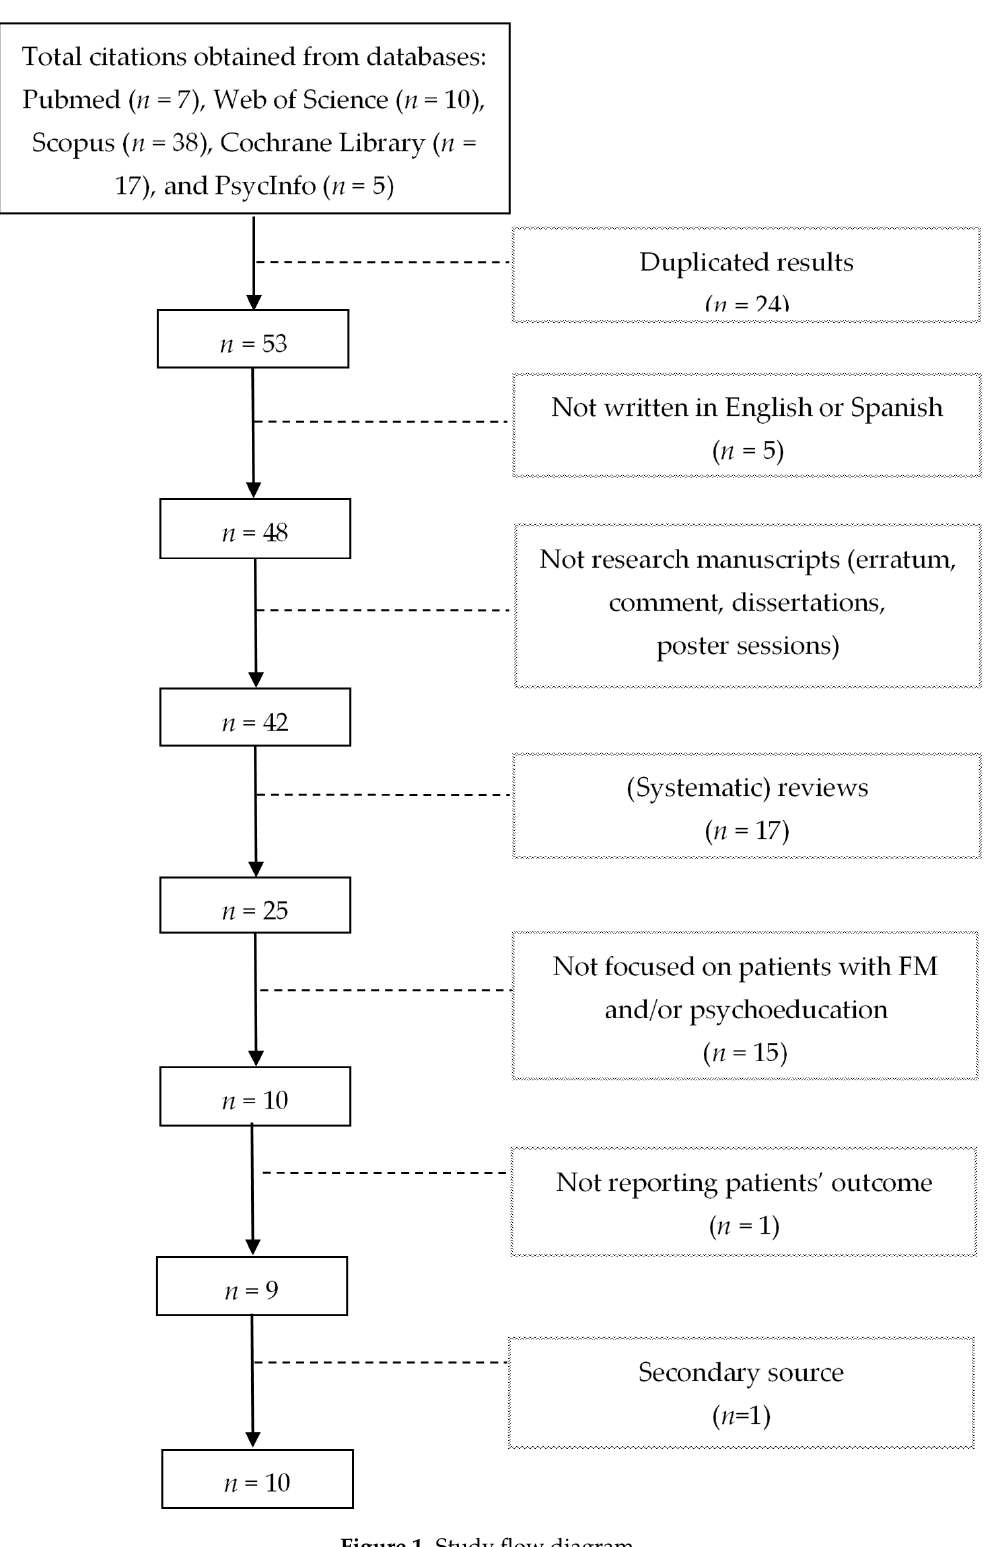
Figure 1. Study flow diagram.